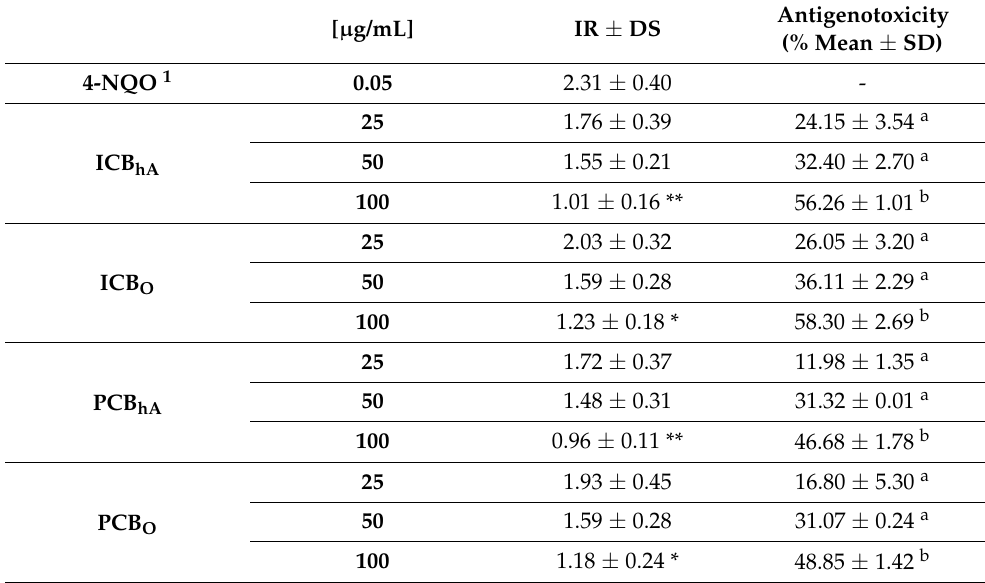
Table 3. Antigenotoxicity of hydroalcoholic and chloroform extracts of ICB and PCB samples (25, 50, 100 µ g/mL) after co-incubation with standard genotoxin 4-NQO (0.05 µ g/mL). Results are expressed as mean of induction ratio (IR) ± SD ( n = 3) with significant difference for * p < 0.05 and ** p < 0.01 ( Dunnett’s test ) calculated comparing IR values obtained from extracts co-treated with standard genotoxin to IR values obtained from single standard genotoxin, and as mean of antigenotoxicity % ± SD( n = 3). [ µ g/mL] IR ±